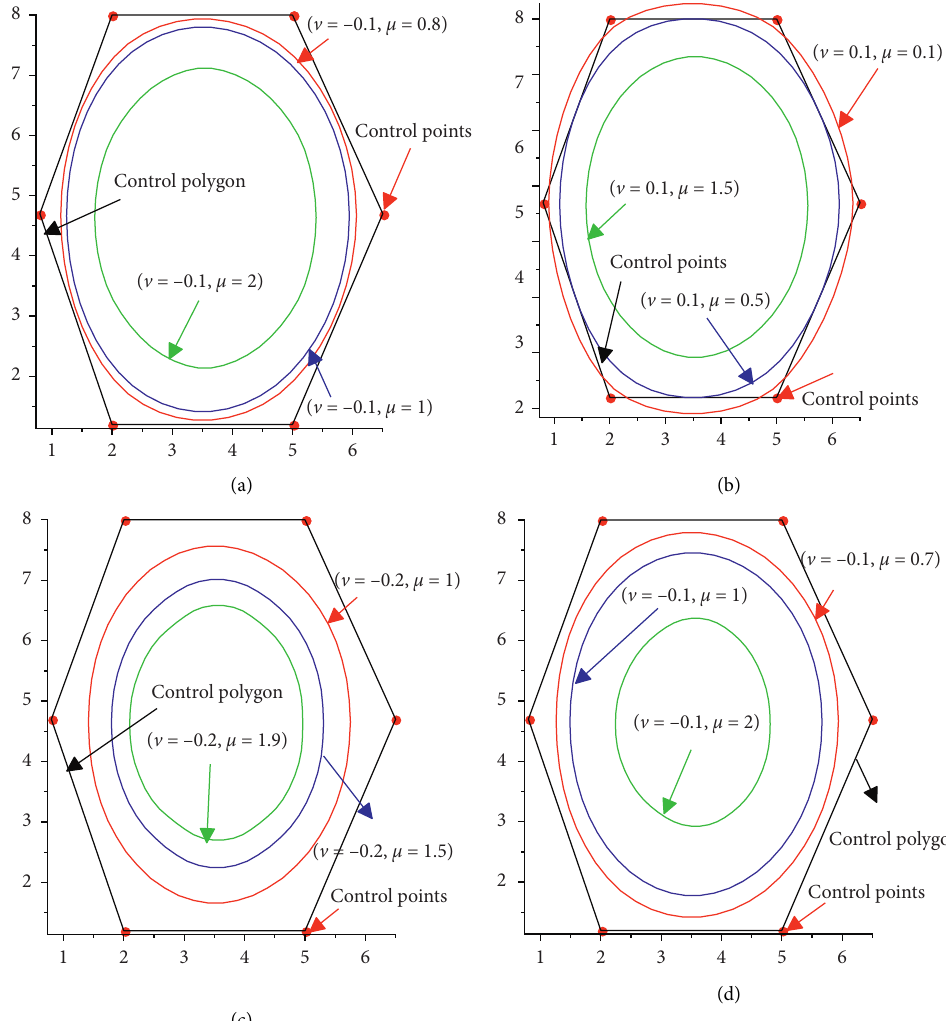
Figure 6: Red bullets show the initial control points. Black solid lines are the initial control polygon. Coloured lines show curves fitted by our subdivision scheme after two refinement steps. (a) 4-point combined scheme ] � − 0 . 1 , μ � 0 . 1 , 0 . 5 , 1 . 5; (b) 4-point combined scheme ] � 0 . 1 , μ � 0 . 1 , 0 . 5 , 1 . 5; (c) 6-point combined scheme ] � − 0 . 1 , μ � 1 , 1 . 5 , 1 . 9; and (d) 6-point combined scheme ] � − 0 . 3 , μ � 1 , 1 . 3 , 1 .